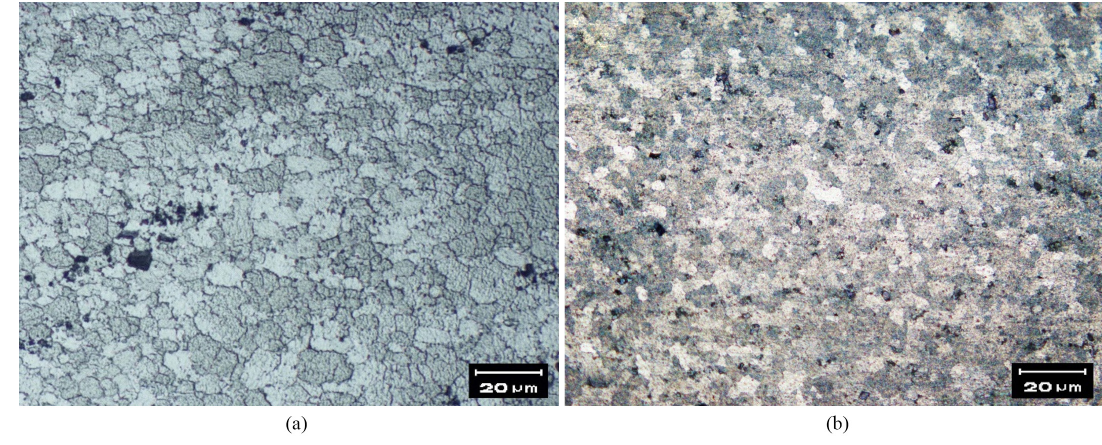
Figure 6. SZ micrograph of the (a) Al